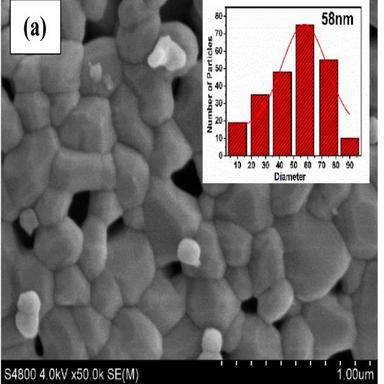
(a-d, a′-d′): SEM images, and histograms of Mg1-xCoxFe2O4 with (x = 0, 0.03, 0.06, and 0.09) nanoparticles and (a′-d′) EDX spectra of Mg1-xCoxFe2O4 with (x = 0, 0.03, 0.06, and 0.09) nanoparticles.